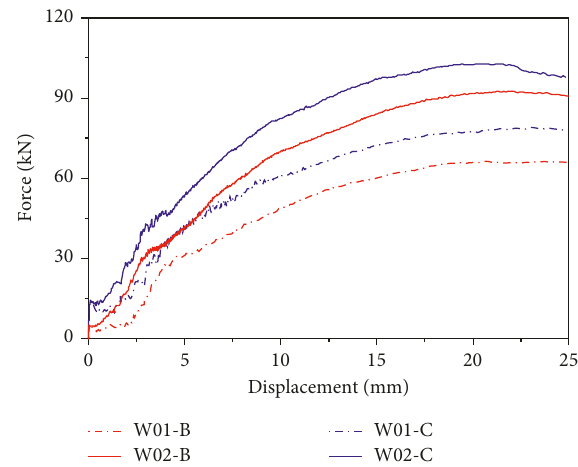
Figure 11: Load-displacement response of W01 and W02 log-haus assemblies (ABAQUS), depending upon the level of compressive vertical loads (“B” 5kN/m and “C” 15 (cid:30) (cid:30)